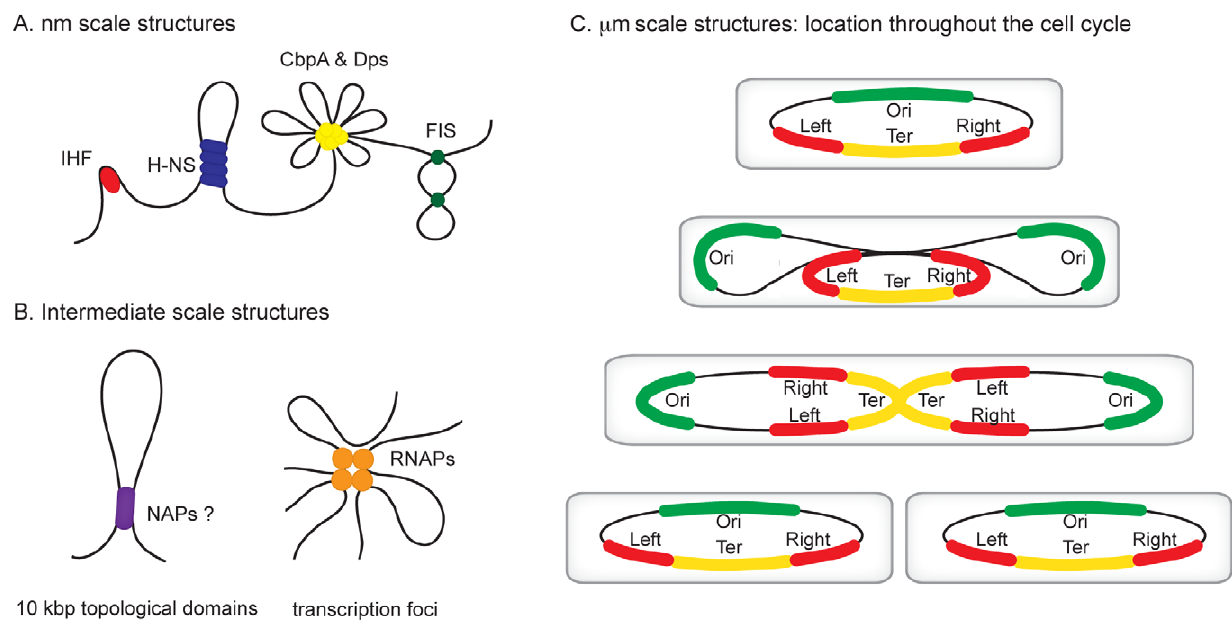
Figure 1. Hierarchical levels of organization in bacterial chromosomes. Different levels of organization exist within bacterial chromosomes. (A) At the nm scale nucleoid proteins such as HU, H-NS, CbpA, Dps, and Fis organize the genome by driving events such as DNA bending, bridging, and aggregation. (B) Structures such as seen in (A) likely exist within, and may contribute towards the formation of looped topological domains (on average each , 10 kbp in size) and transcription foci, where multiple transcribing RNA polymerase molecules are clustered potentially also yielding loops along the genome. (C) All of the above could add to the complexity of the organization within individual macrodomains. The individual macrodomains have a defined localization within the cell throughout the cell cycle. In newborn cells ori and ter are located at mid-cell positions. These sites are located centrally within the Ori and Ter macrodomains. The Left and Right macrodomains occupy positions close to the cell poles. Upon replication, the Ori domains move towards the cell poles. Right before cell division the replicated Ter domains segregate. The chromosome in the daughter cells has again the same Left-Right orientation. MatP preferentially occupies sites in the Ter domain, whereas SlmA and SeqA are absent from this